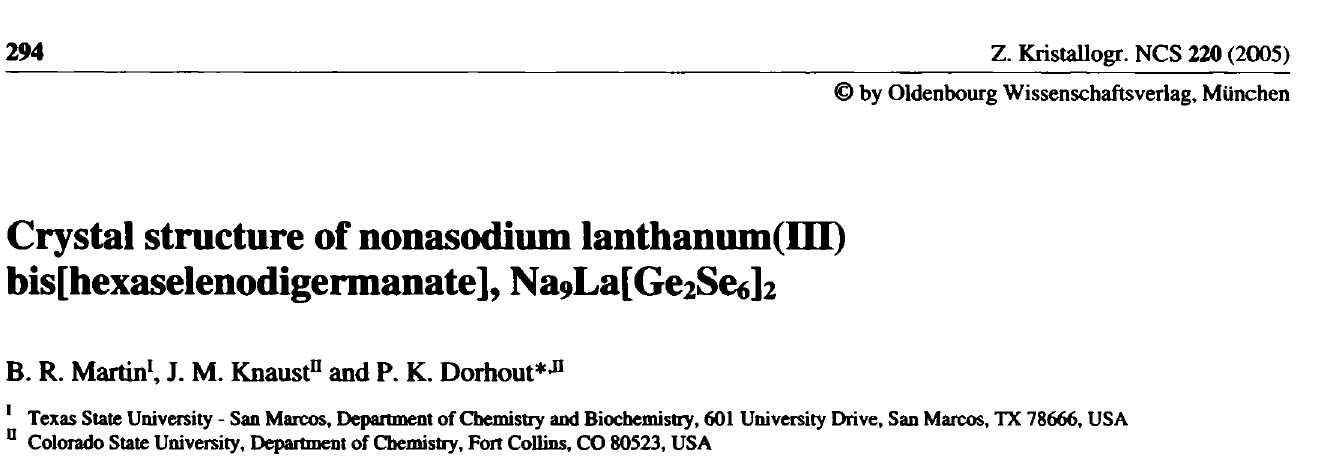
Table 1. Data collection and handling.